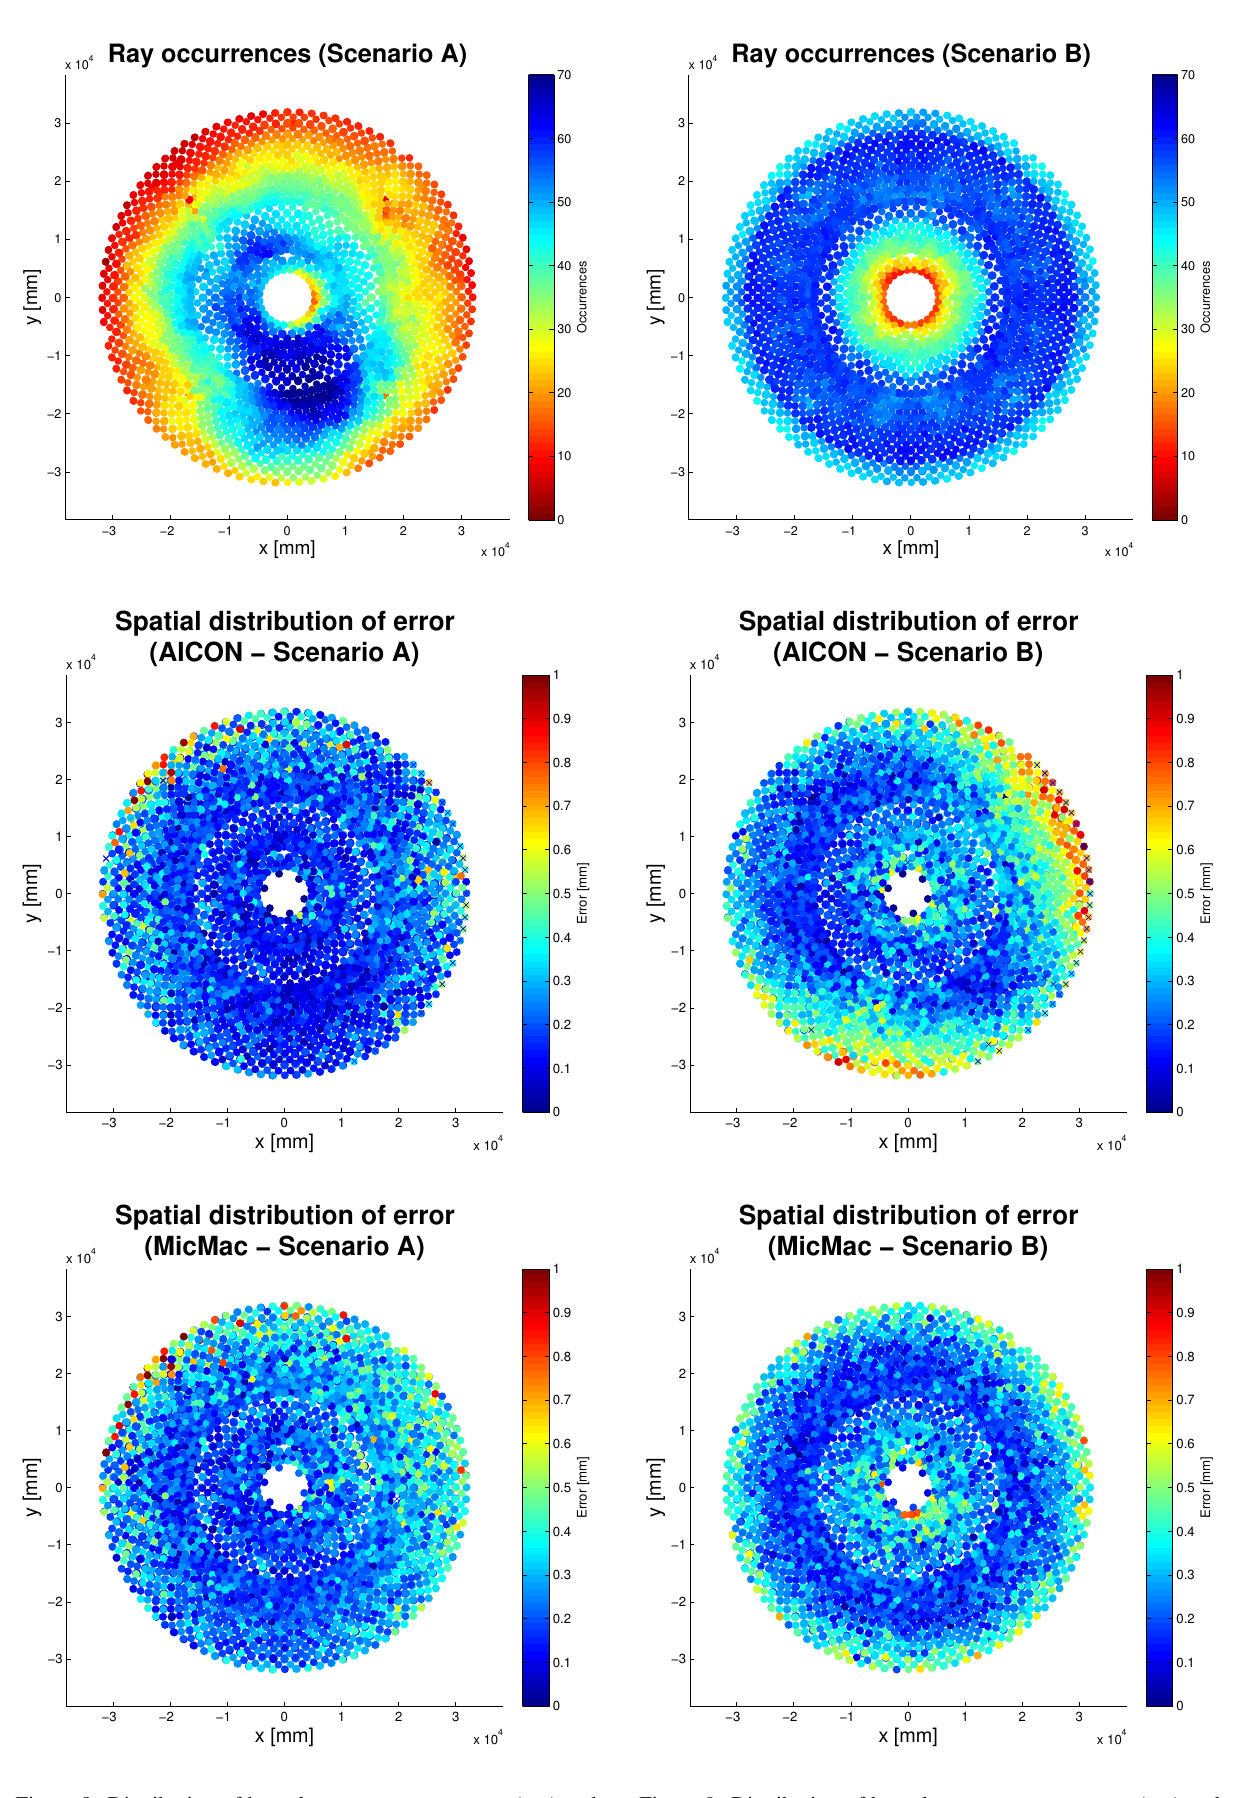
Figure 8: Distribution of homologous ray occurrences (top) and spatial distribution of error (middle and bottom) for Scenario A.